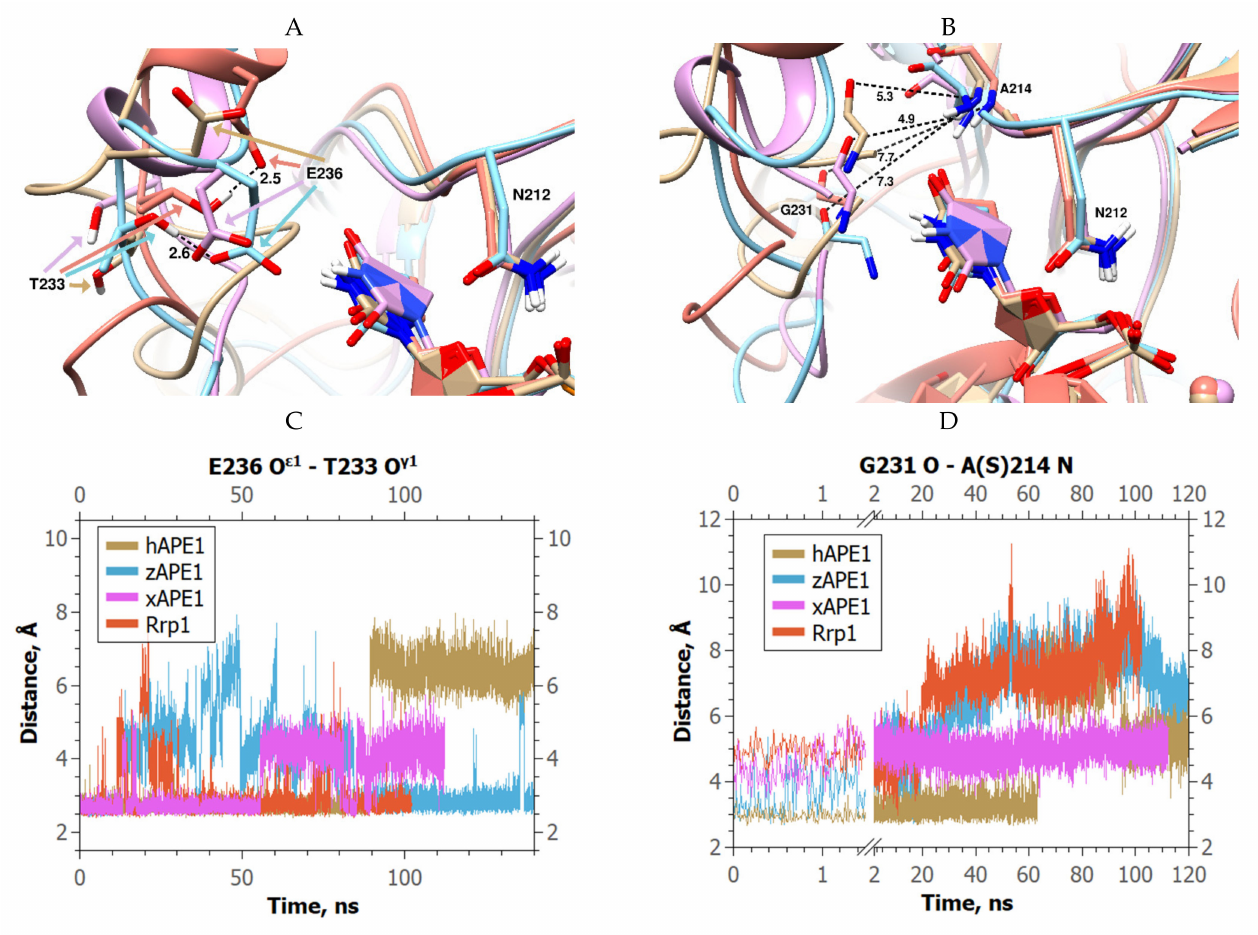
Figure 5. Changes in the damage-recognition loop in the complexes of the investigated APE1-like enzymes with DHU-containing DNA (hAPE1 is sand-colored, zAPE1 is cyan, xAPE1 is magenta, and Rrp1 is red): ( A ) Changes in the Asn229–Thr233 residues in the complexes of the four enzymes with DHU-containing DNA; ( B ) alternations of the DHU O5 (cid:48) –His309 N ε 2 distance for different enzymes. Black dashed lines indicate unsevered H-bonds; overall changes in Thr233 O γ 1 –Glu236 O ε 1 ( C ) and Gly231 O–Ala214 N ( D ) distances in different complexes throughout the MD